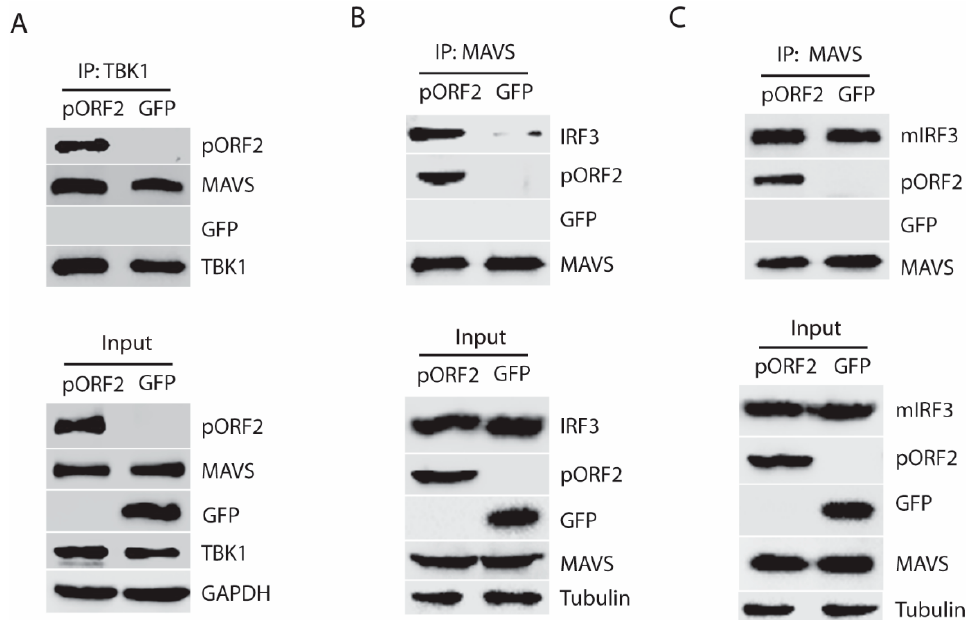
Figure 5. The capsid protein inhibits the dissociation of IRF3 from the MAVS-TBK1 complex. ( A ) TBK1 interacts with ORF2 in the presence of MAVS. HEK293T cells were co-transfected with TBK1, pORF2, and MAVS, and the Co-IP was performed at 36 hpt with the HA-TBK1 antibody. The IP product and input were subjected to WB detection with pORF2, TBK1, MAVS, and GFP antibodies. ( B ) MAVS IP precipitates IRF3 and pORF2, whereas much less IRF3 in the control of GFP. The HEK293T cells were transfected with plasmids of Myc-MAVS, IRF3, and pORF2. Co-IP was done with the Myc-MAVS antibody, and the product was detected by WB with antibodies against MAVS, IRF3, and pORF2. WB of input cell lysate is shown in the lower panel. ( C ) The presence of ORF2 does not a ff ect mutant IRF3 interaction with MAVS. The HEK293T cells were transfected with plasmids of Myc-MAVS, mutant IRF3 (S385A / S386A), and pORF2. The Co-IP detection was done as panel B.